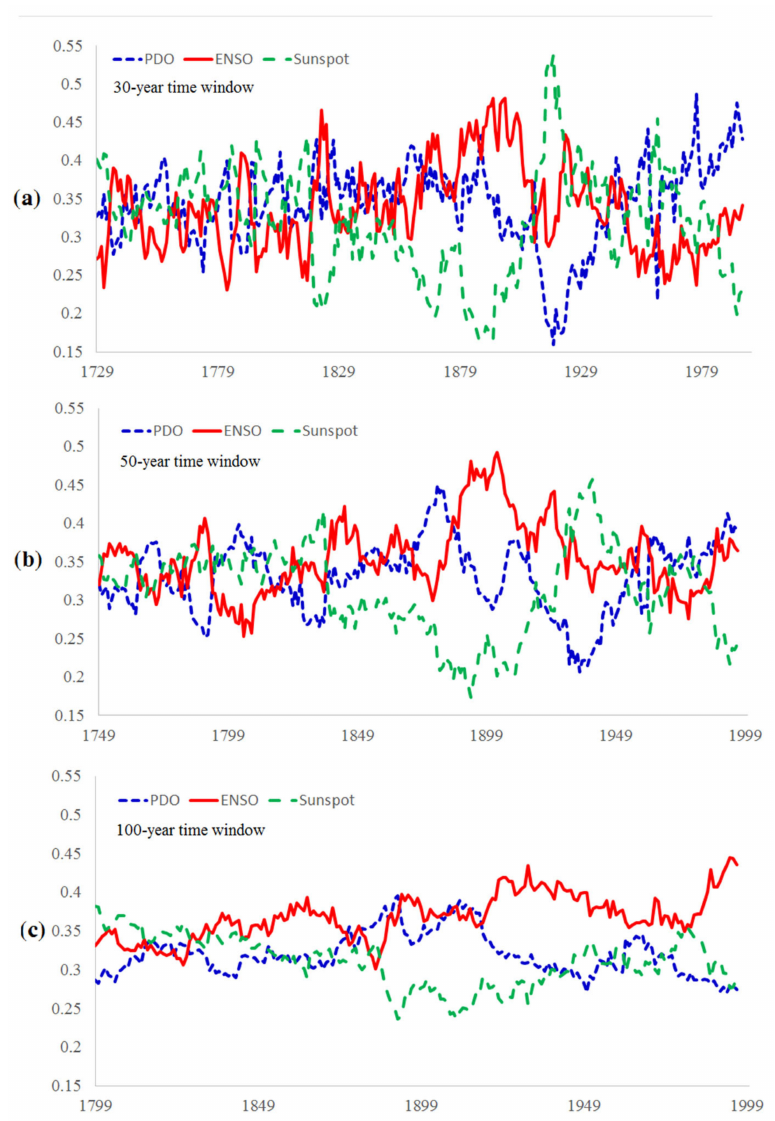
Figure 10. Temporal dynamic of the relative influential rate of each factor to drought change, ( a ) for 30-year time window, ( b ) for 50-year and ( c ) for